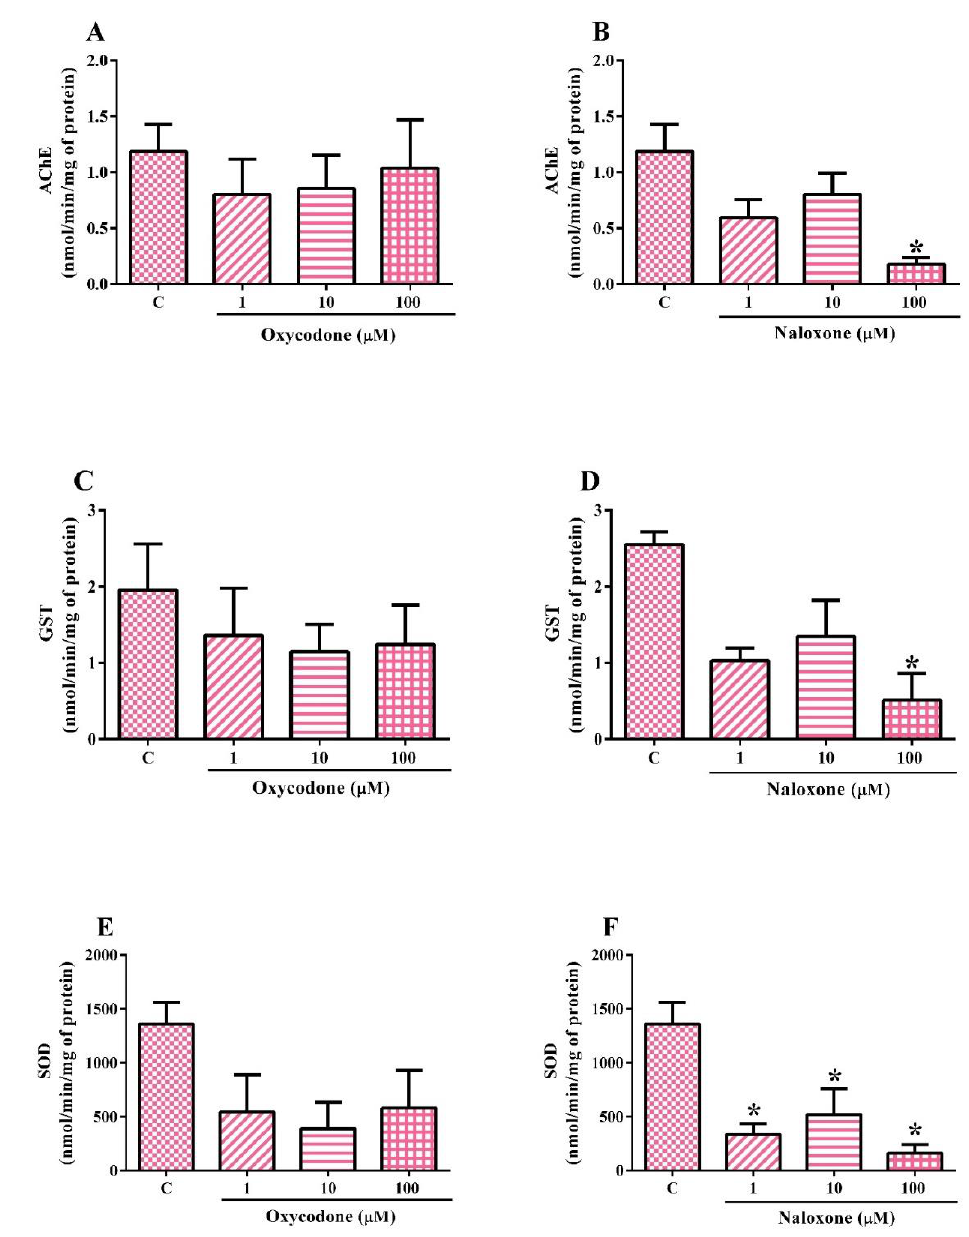
Figure 4. Biochemical analysis of a neuroblastoma cell line (SH-SY5Y) exposed for 24 h to oxycodone ( A , C , E ) and naloxone ( B , D , F ). The results were analyzed by one-way ANOVA followed by Dunnett’s post-test and presented as the mean ± SEM ( n = 2–3). C: control, nonexposed cells. * Statistically different from C.